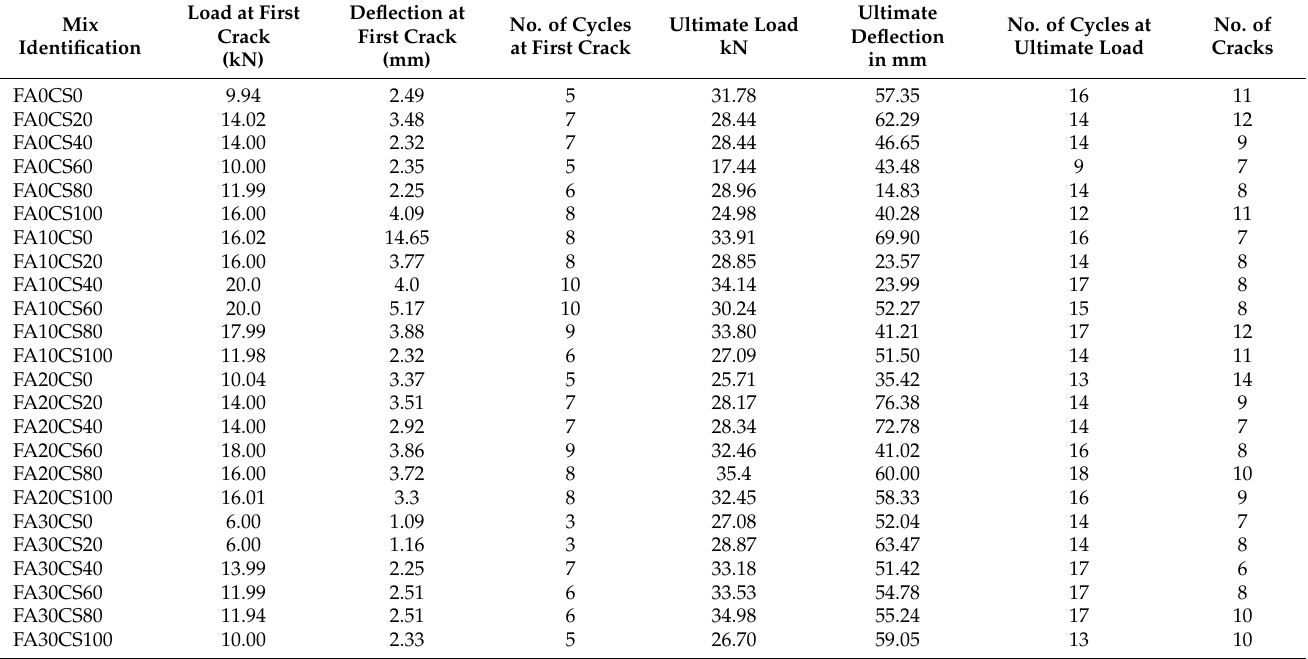
Table 7. Experimental results of cyclic loadings and their